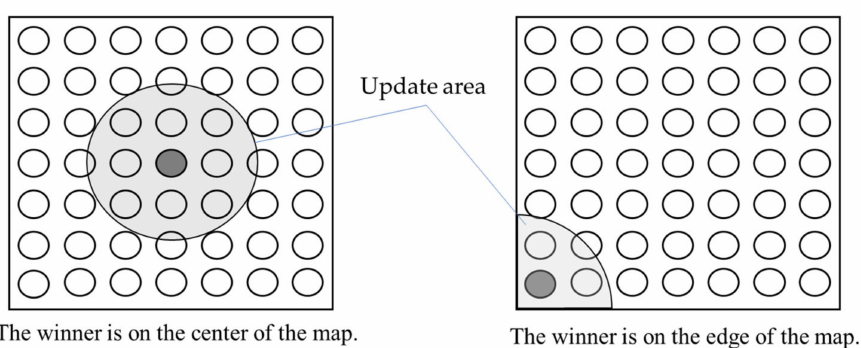
Figure 3. Difference in the update area depending on the positions of the winner